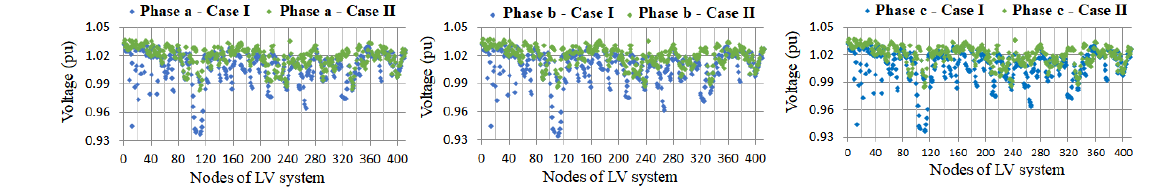
Figure 3. Voltage in the LV system: Cases I and II.